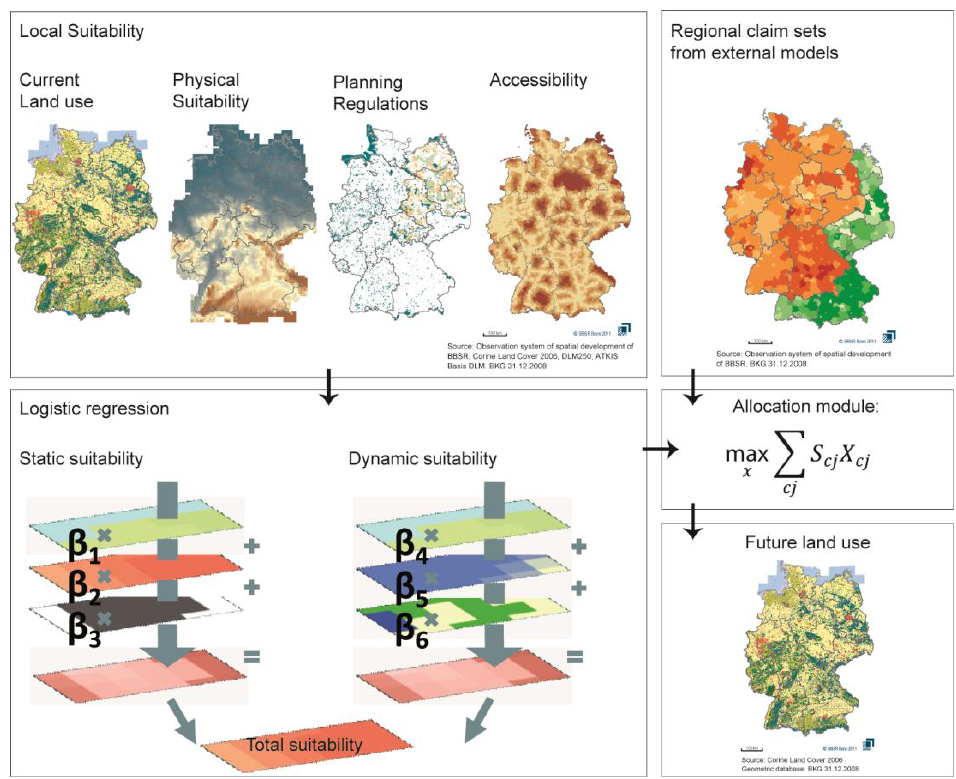
Figure 1. Overview of the German Land Use Scanner model application.